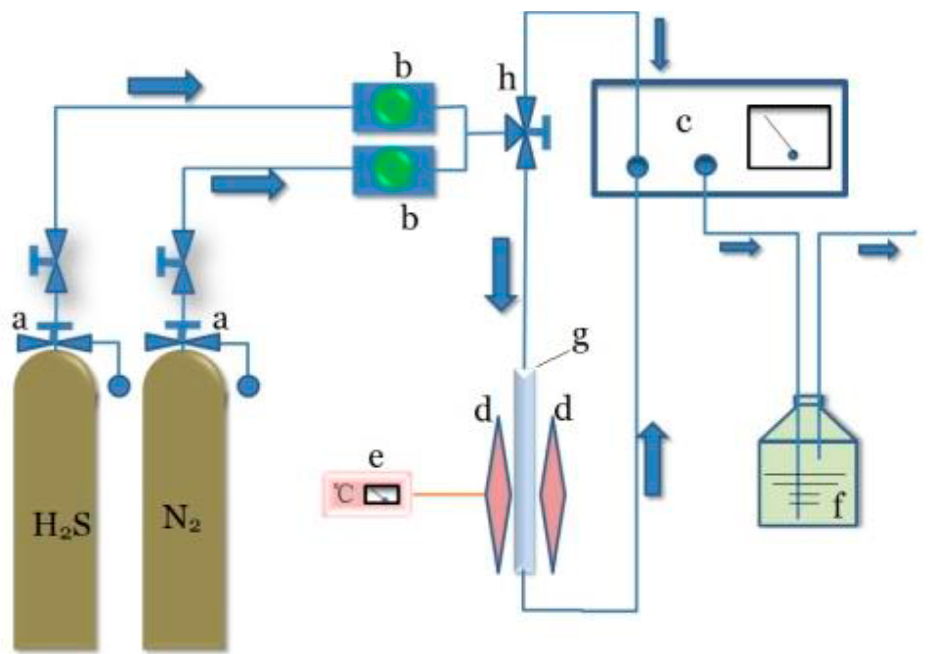
Figure 12. The diagram of test devices for the evaluation of desulfurization performance. ( a ) Pressure reducing valve; ( b ) mass flow controller; ( c ) portable hydrogen sulfide concentration analyzer; ( d ) tube furnace; ( e ) temperature controller; ( f ) concentrated lye; ( g ) quartz tube; ( h ) three-way valve.